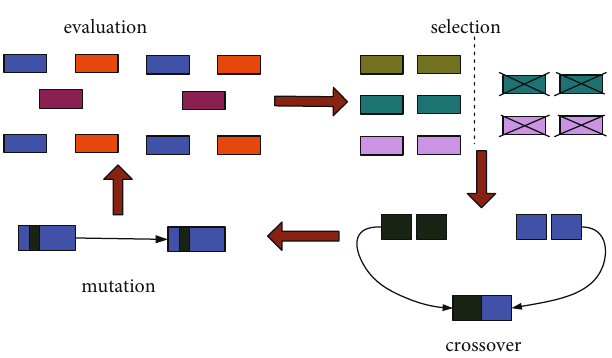
Figure 3: The structure diagram of the genetic algorithm.